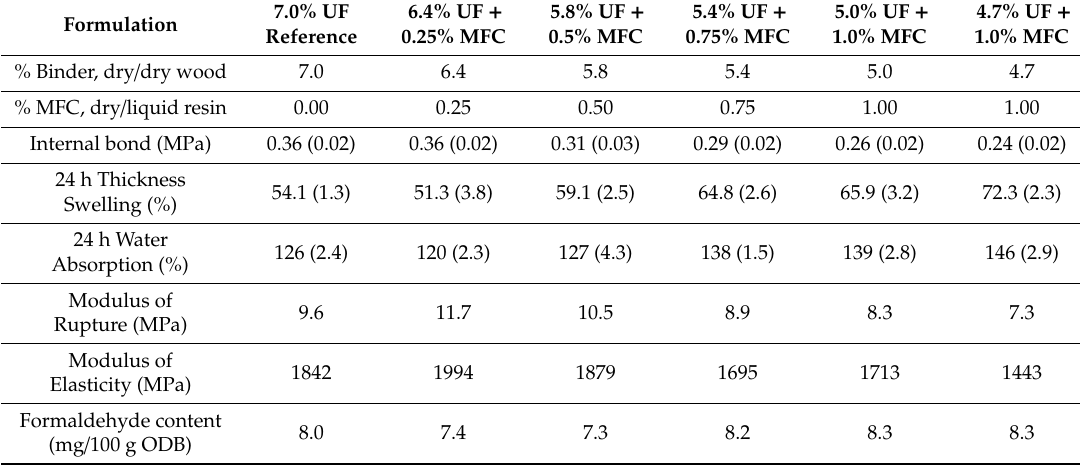
Table 4. Particleboard panels analysis, MFC 10% increasing levels, resin decreasing, Approach 2, Average property values, Standard deviation (in